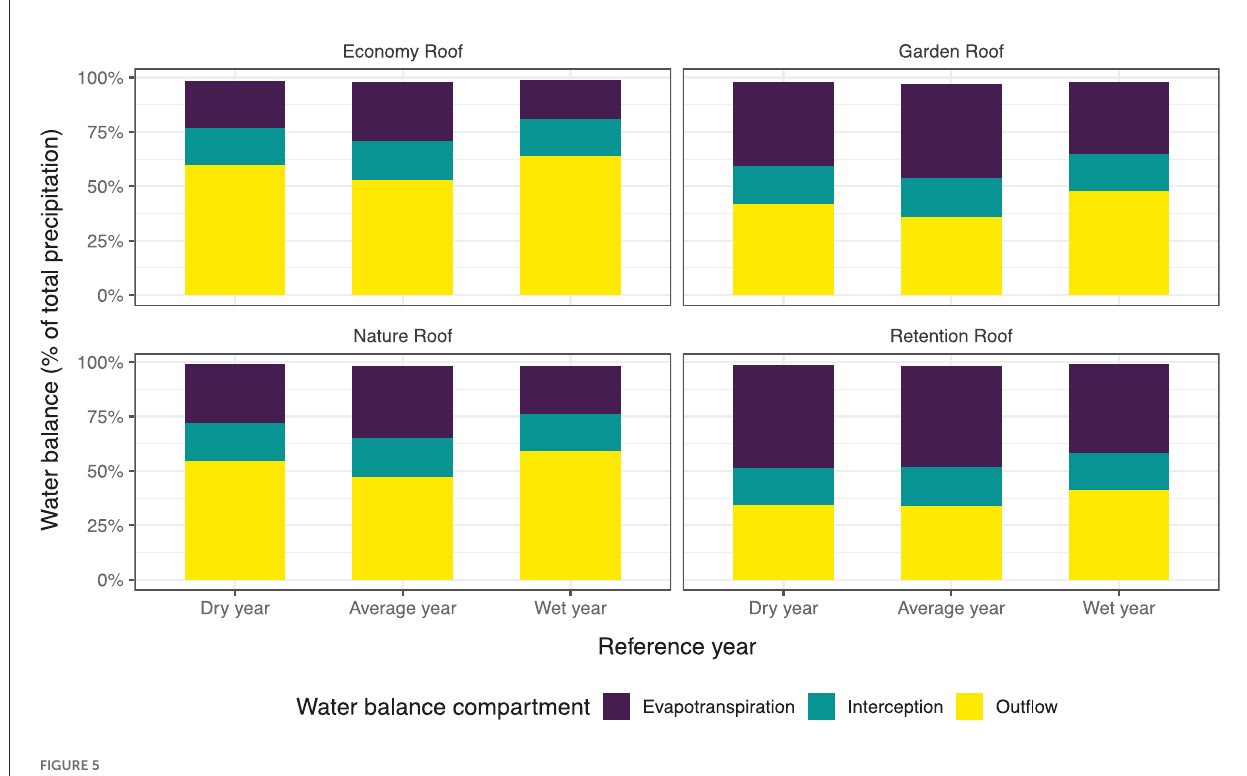
FIGURE5 Overall water balance for predicted extreme dry, extreme wet, and average (ensemble) reference years based on 31 years of precipitation and reference evapotranspiration data for DWD station Pfullendorf (1991–2021). GR2L was run with calibrated parameters for each green roof type. Actual evapotranspiration, interception, and outflow are expressed as a fraction of total annual precipitation